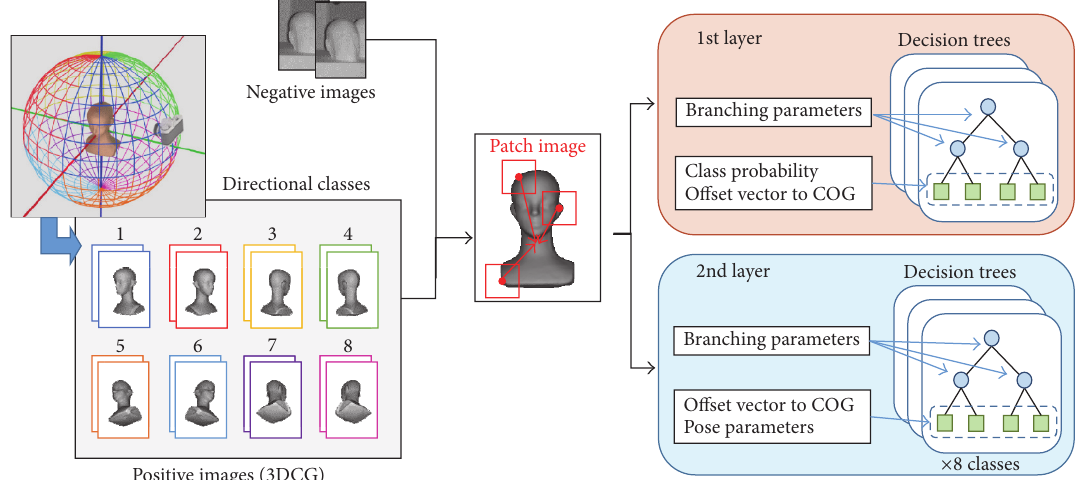
Figure 2: Training flow with multilayered Random